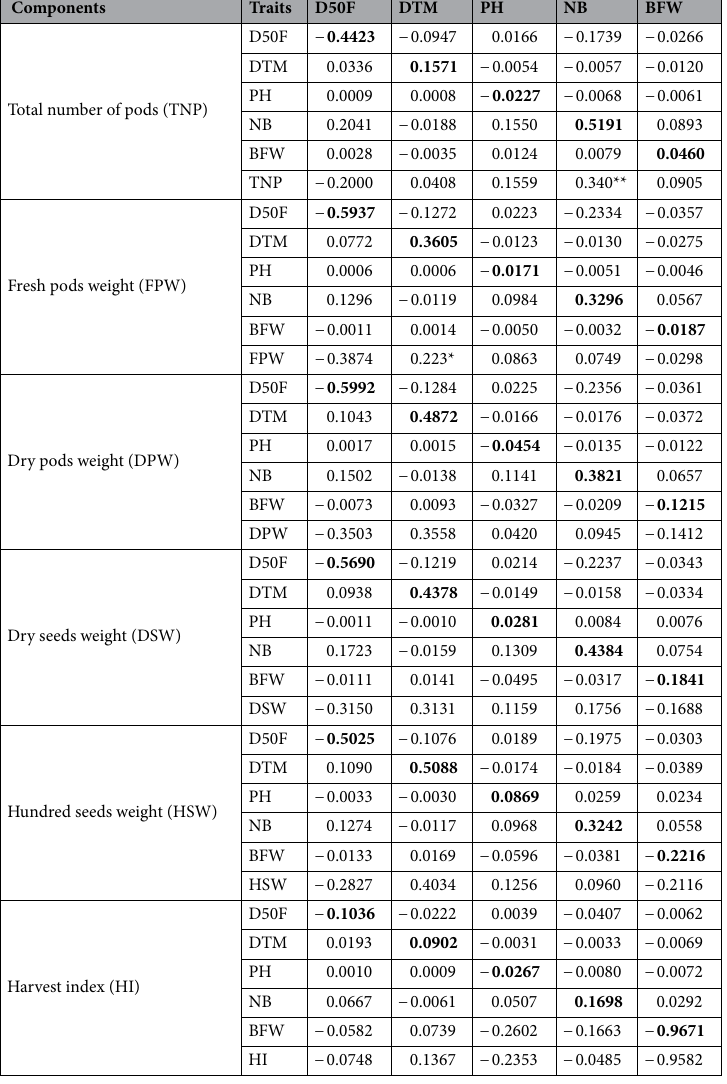
Table 9. First order and second-order component relationships. D50%F = days to 50% flowering, DTM = days to maturiity, PH = plant height (cm), NB = number of branches, BFW = biomass fresh weight